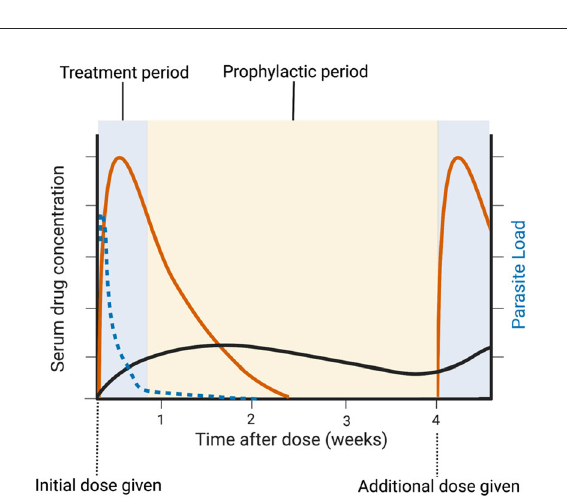
FIGURE2 Idealized IPTp regimen. A treatment dose of a drug that meets MMV TPP-1 (management, orange line) eradicates existing asexual and placental infection (dotted blue line). A drug that meets TPP-2 (chemoprevention, black line) provides long-term protection against re-infection until the next prenatal